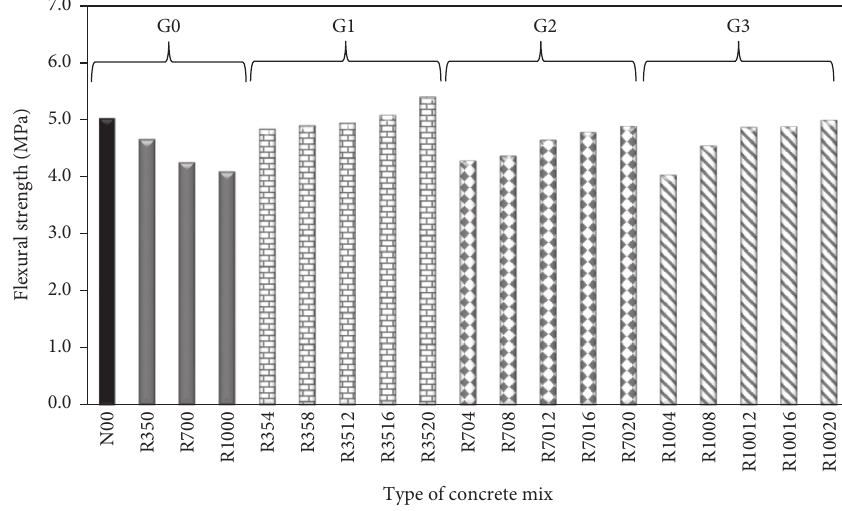
Figure 14: Flexural strength after 28 days of Table 7: Modulus of elasticity (results and normalized values).